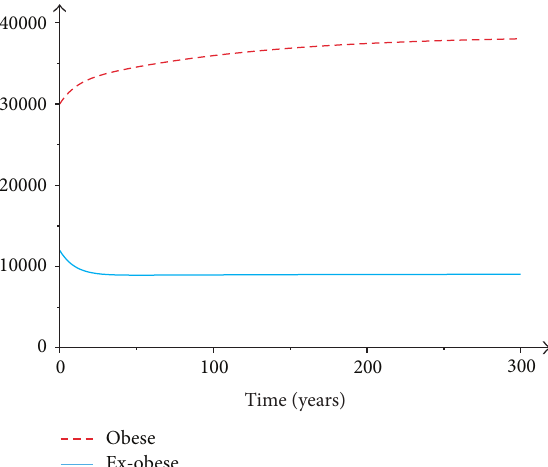
Figure 10: Infected (obese) and recovered (ex-obese) individuals as function of time. Here 𝜖 = 0 , 𝑅 0 = 0.3 , and the initial condition is (𝐼(0),𝑅(0)) = (10000, 30000) .